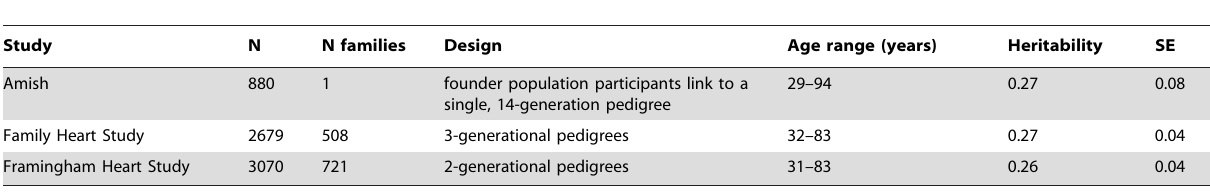
Table 1. Characterization of family data for heritability